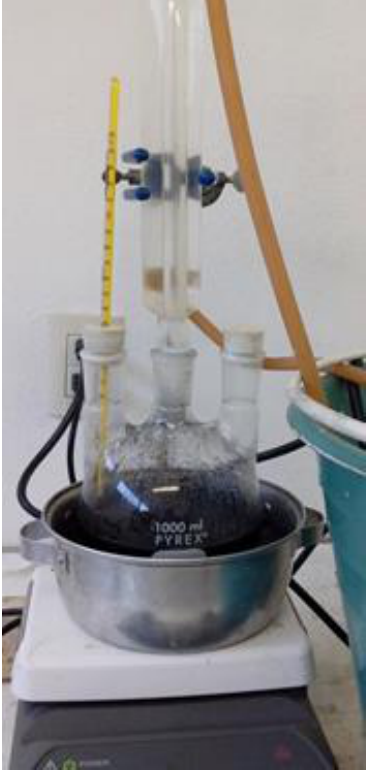
Figure 5. Experimental setup for acid leaching.